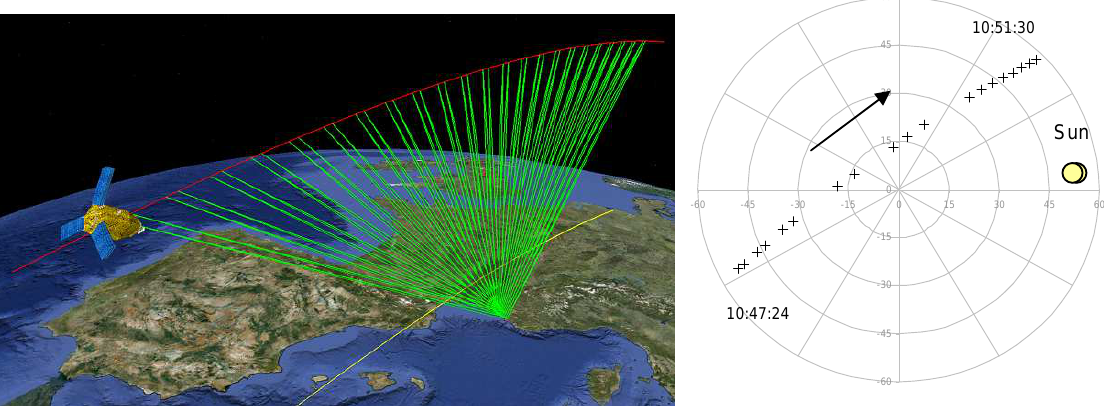
Figure 6 : Acquisitions of 23 quasi-simultaneously images over La Crau (Left: satellite orbit and acquisitions ; right: position of the acquisitions in a polar graph, relative to the solar principal